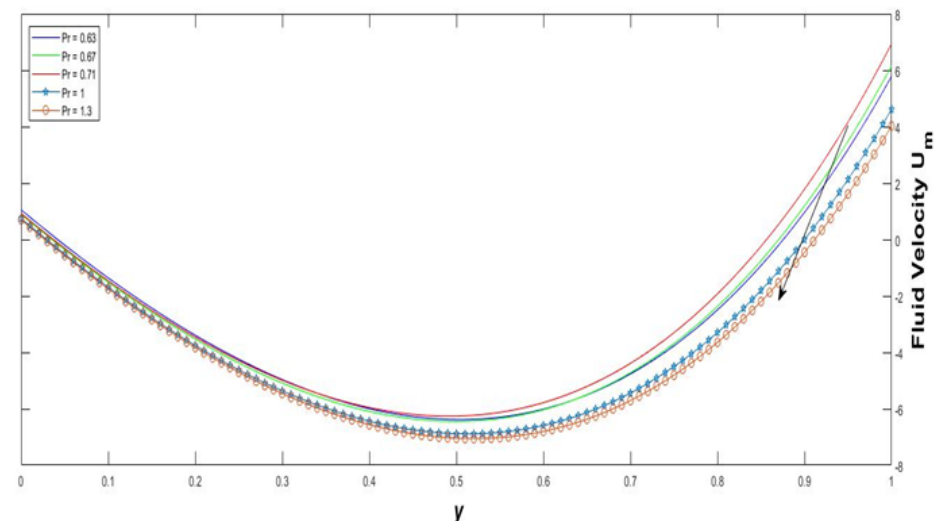
Figure 11. Velocity field for various time ranges.